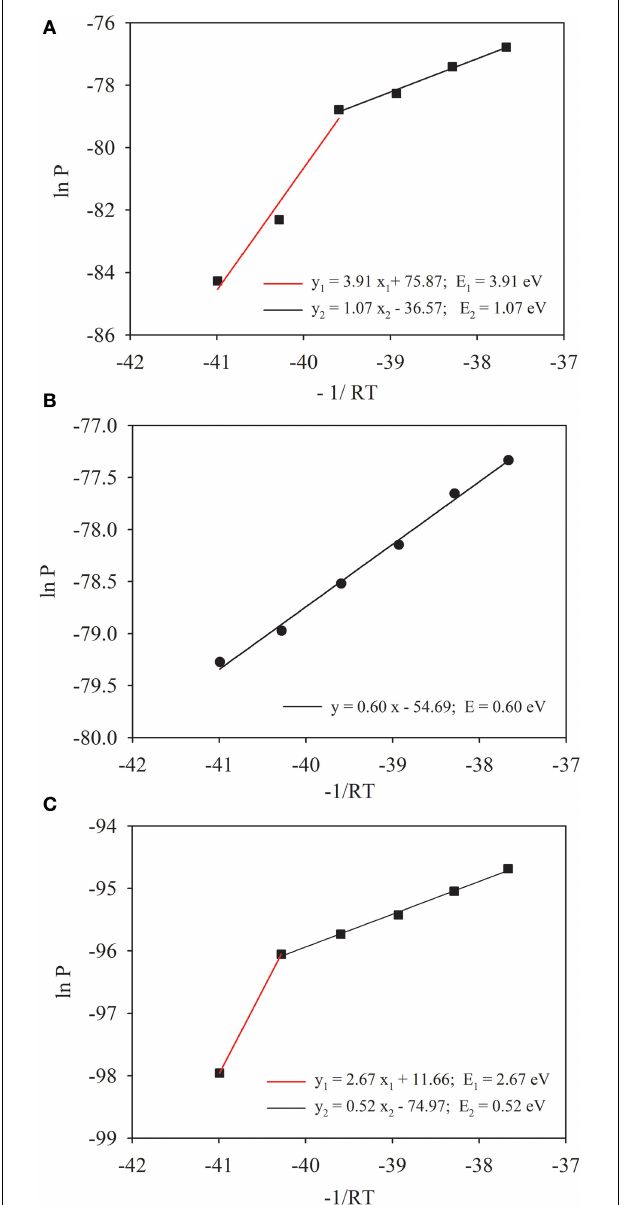
FIGURE 1 | Temperature dependences of CH 4 (A) and CO 2 (B) production in Zoige wetland. Temperature dependence was characterized through plotting Arrhenius equation with “lnP” as a function of “ − 1/RT,” where P is the maximal rate of CH 4 production, T is the absolute temperature and R is the Boltzmann constant (8 . 623 NU × 10 − 5 eV K − 1 ). To take into account the effect of enzyme abundance, the maximal rate of CH 4 production was normalized against the abundance of mcrA (C) . Solid lines [except the red line in (C) ] are the regression fits, where the slope indicates the apparent activation energy E